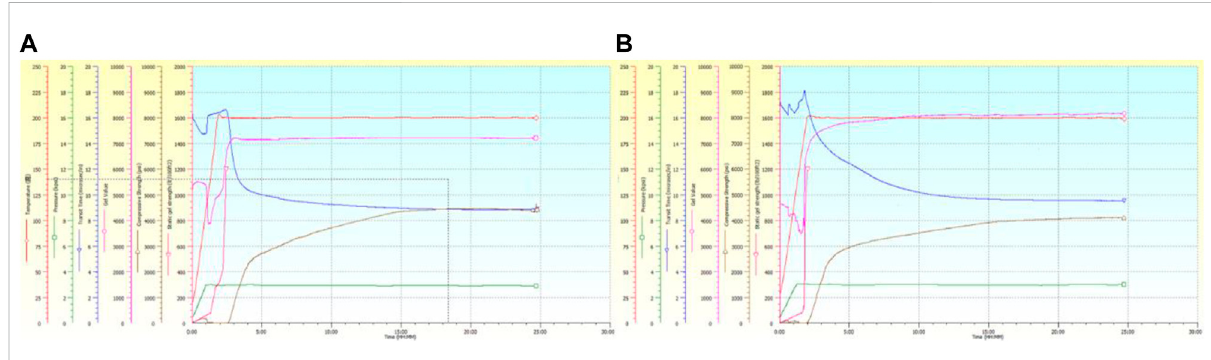
FIGURE 9 Development of gel strength of multi component composite corrosion resistant cement slurry system. (A) :1.9 g/cm 3 ; (B) :2.4 g/cm 3 ).